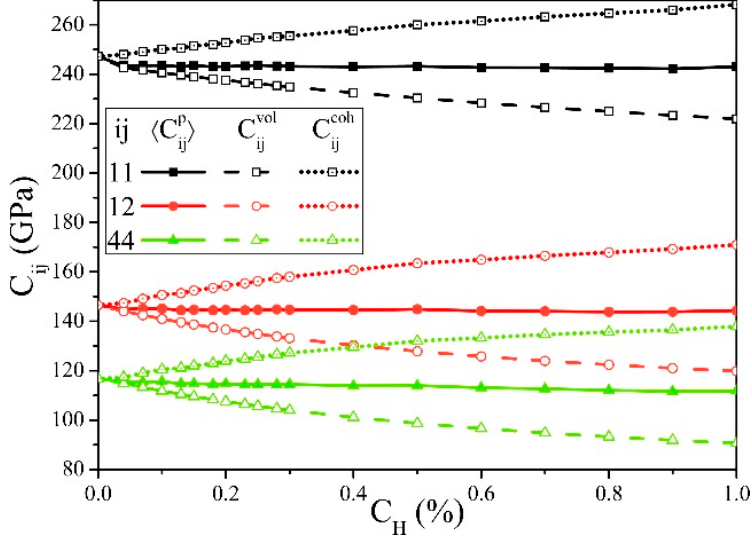
Figure 2. Elastic constants of α -Fe influenced by hydrogen concentrations ( c H ), in which the 𝐶 (cid:3036)(cid:3037)(cid:3049)(cid:3042)(cid:3039) decreases and the 𝐶 (cid:3036)(cid:3037)(cid:3030)(cid:3042)(cid:3035) increases with the increase of c H .